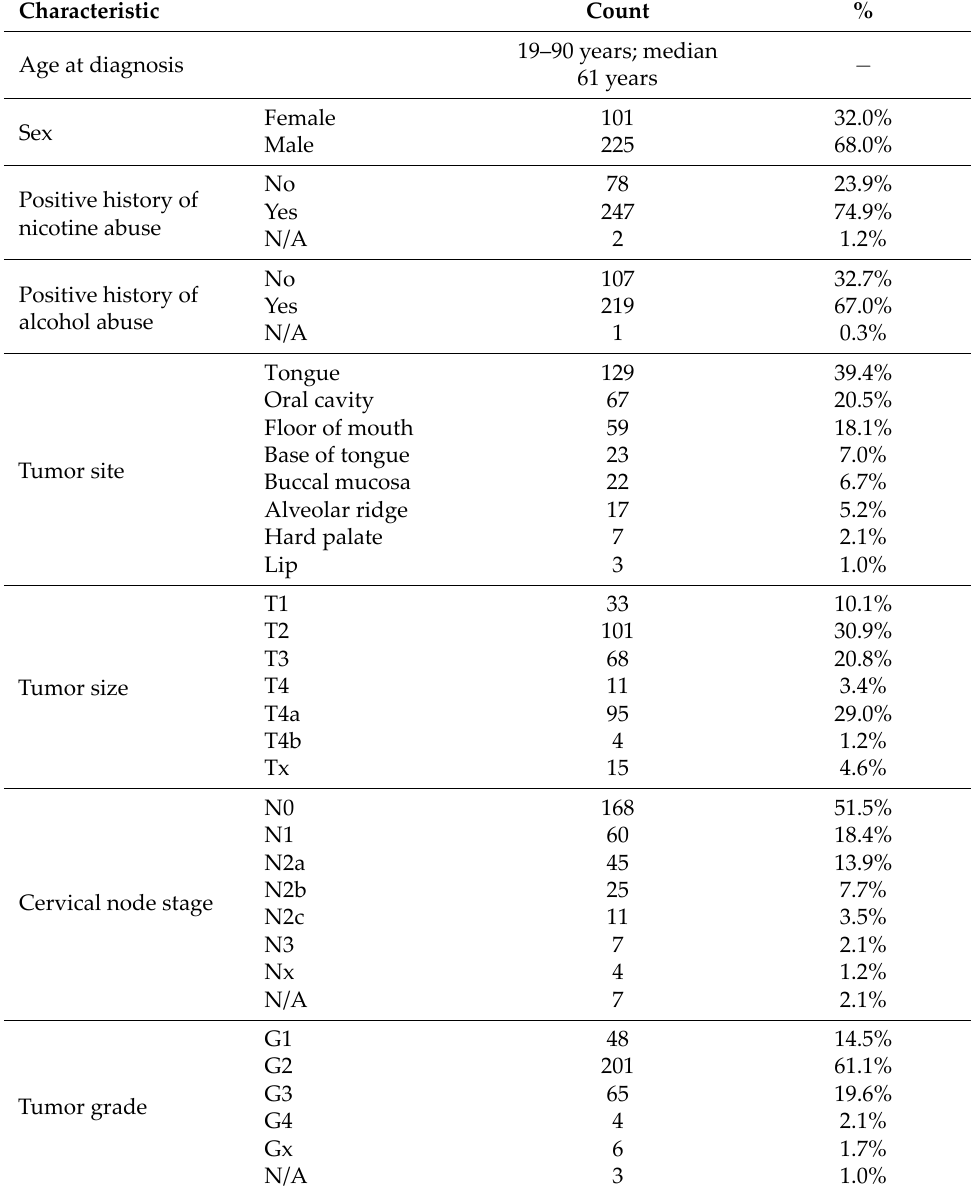
Table 1. Clinicopathological characteristics of the in silico cohort ( n = 327).